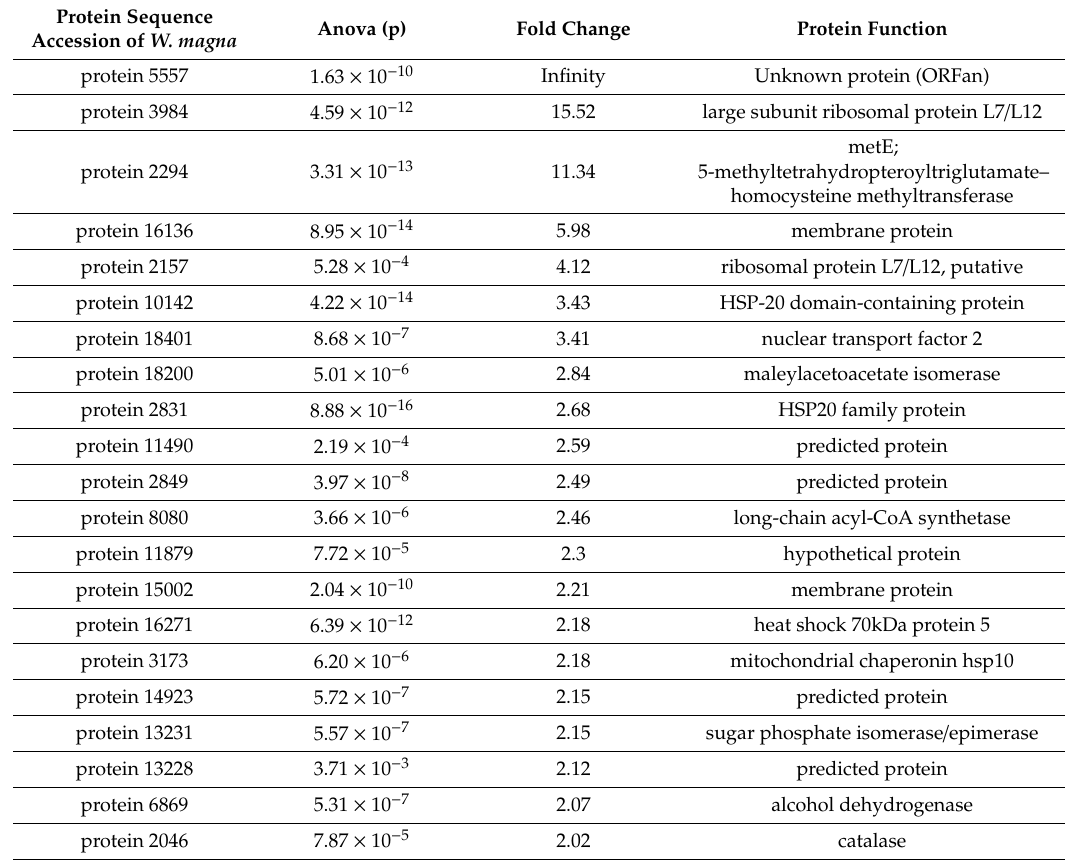
Table 2. Willaertia magna proteins up-regulated in suspension and down-regulated in adhesion culture. Protein Sequence Accession of W.